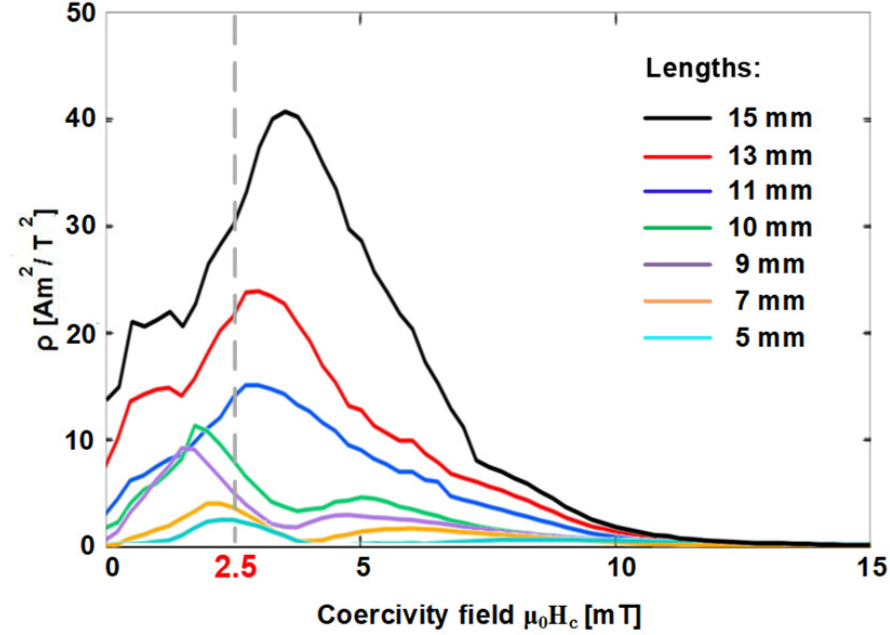
Figure 9. Intensities of FORC distribution under the interaction field μ at varying lengths and field at varying lengths and field intensities.